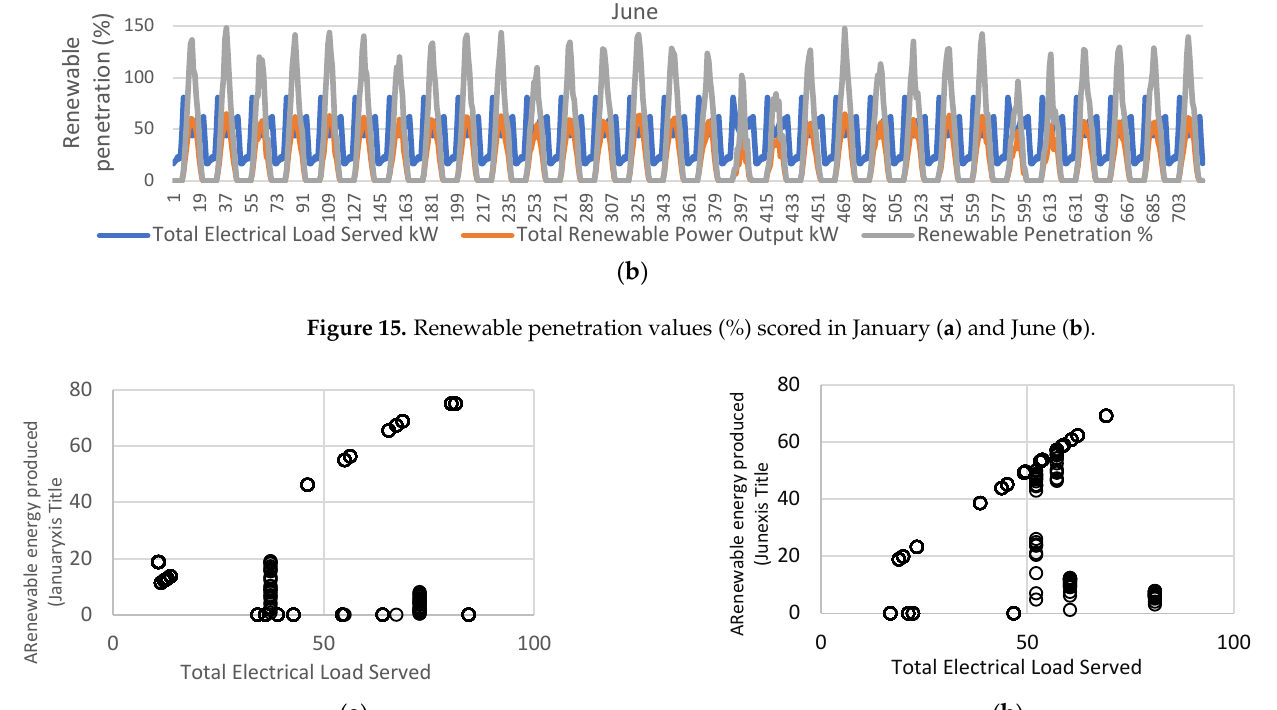
Figure 15. Renewable penetration values (%) scored in January ( a ) and June ( b ).